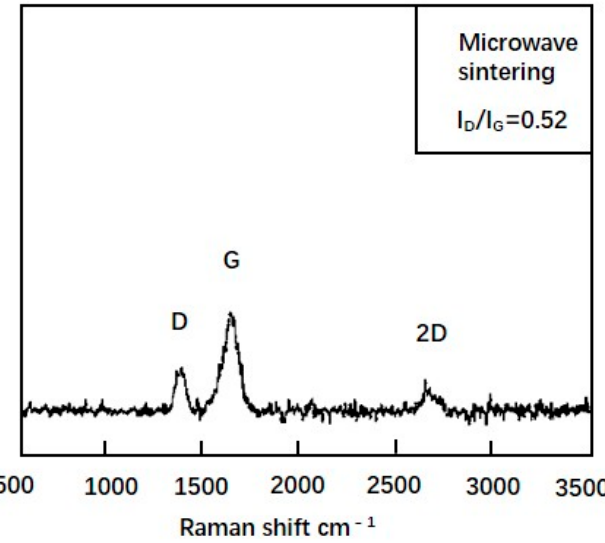
Figure 4. Raman spectra of microwave-prepared bulk composite.